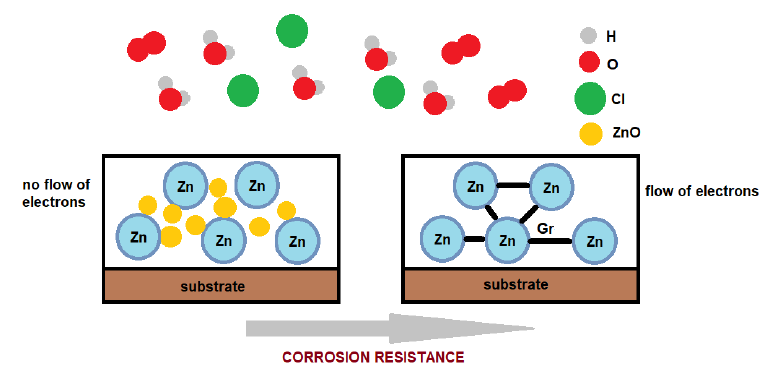
Figure 3. Mechanism protection of zinc-rich polymer coatings.